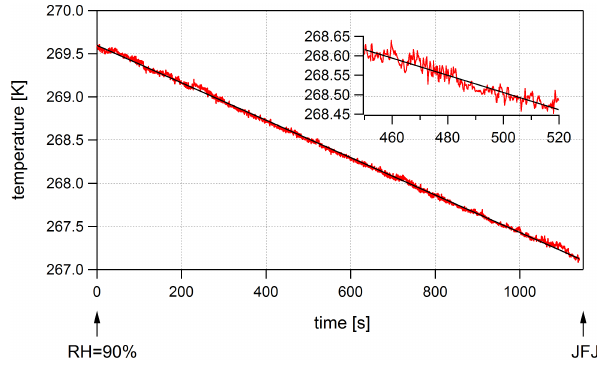
Figure 2. For the model run #516, performed for conditions ob- served on 8 August 2011 18:20UTC, the temperature trajectory is shown with the added small-scale temperature fluctuation ( T turb ) re- trieved from the sonic anemometer measurements (see detailed de- scription in Sect. 2.3.1). The inset shows the trajectory on a smaller scale for a more quantitative view of the small-scale temperature